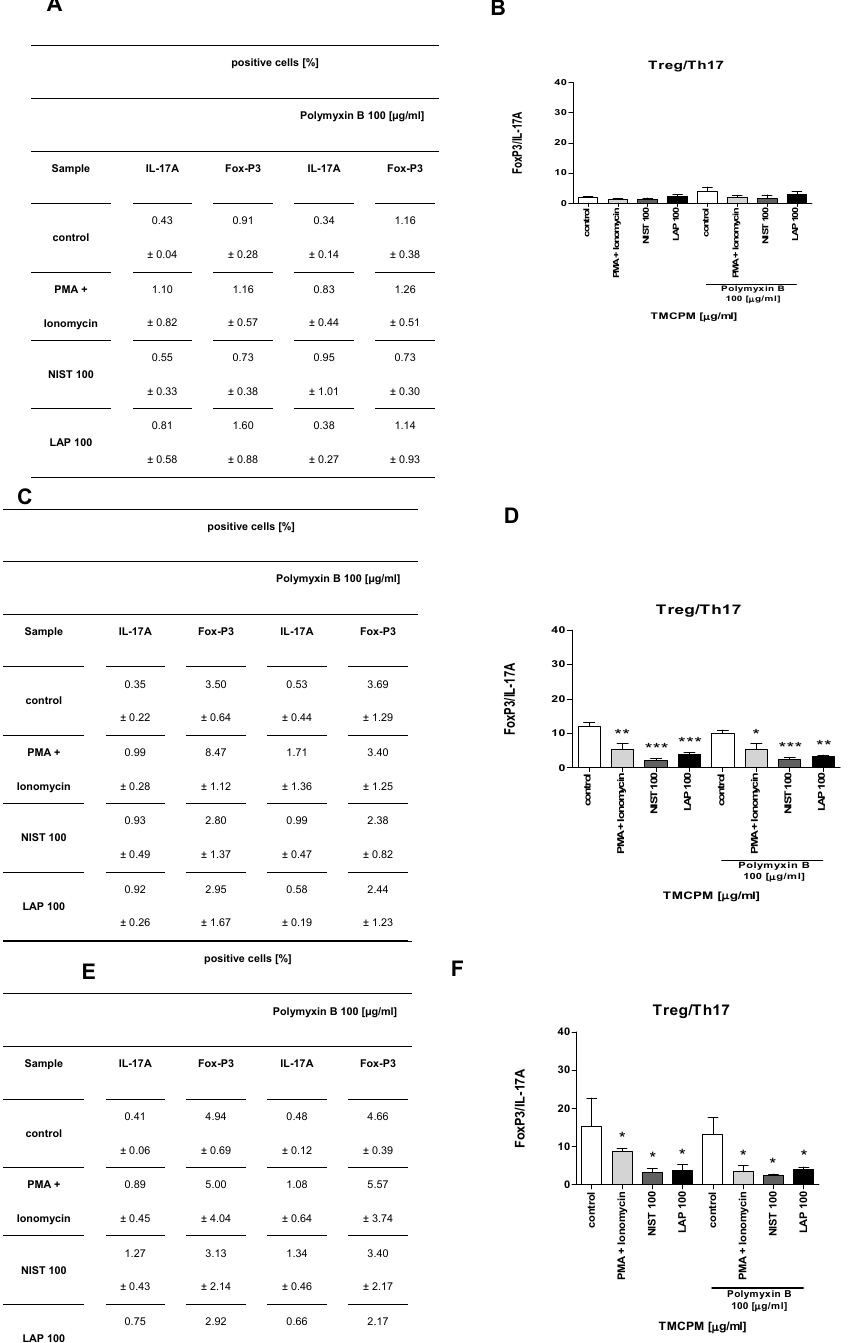
0.56 ± 1.07 Figure 7. Effect of the exposition of T lymphocytes ( A , B ), PBMC ( C , D ) and T lymphocytes with monocytes added ( E , F ) to TMCPM (NIST or LAP) pre-treated with polymyxin B on the Th1/Th2 ratio. Cells were stimulated as described in “Materials and Methods” with PMA (50 ng/mL) + ionomycin